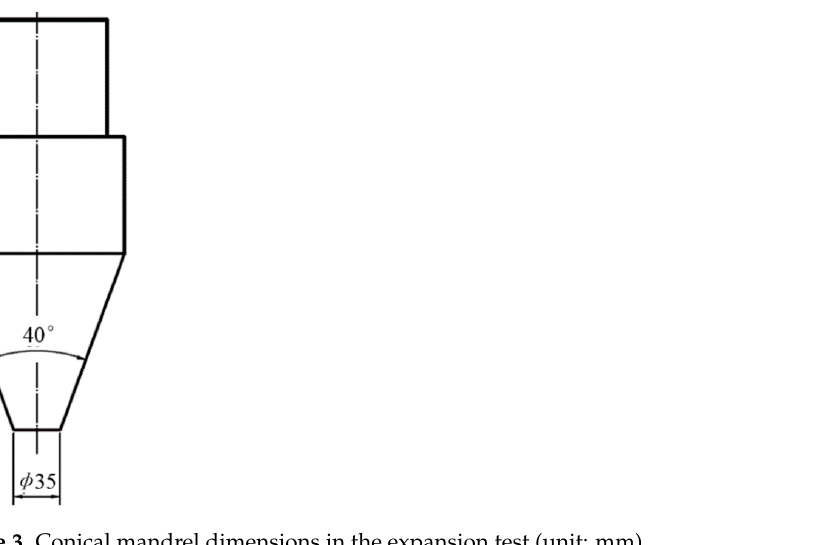
Figure 2. ( a ) Porthole die, ( b ) cross-section shape of the profile, and ( c ) schematic of the extrusion process (unit: mm).